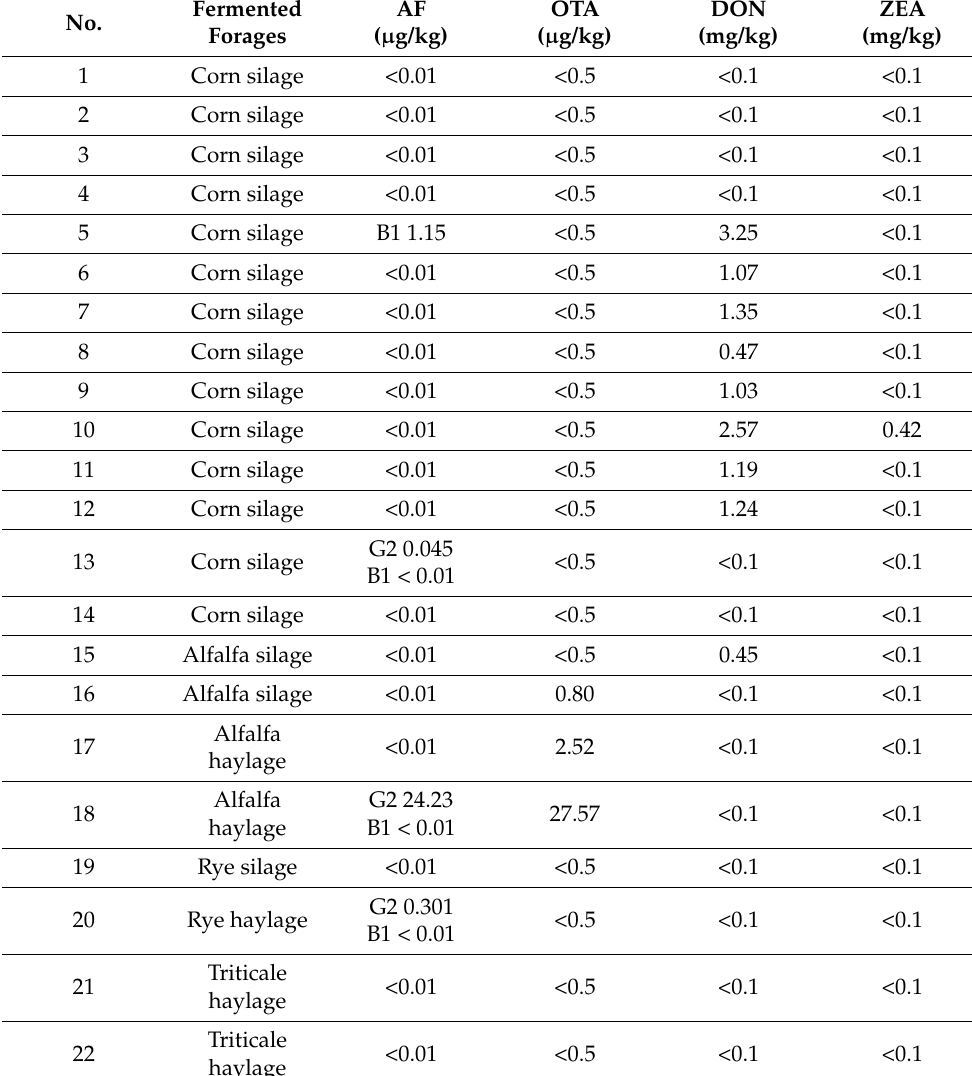
Table 1. Toxicological characterization of the studied fermented forages. Aflatoxins (AF), ochratoxin A (OTA), deoxynivalenol (DON), and zearalenone (ZEA) were measured by HPLC techniques from dried samples ( n = 3, RSD% ≤ 10%) and expressed as mycotoxin contents for dry weights of the fermented forages. The lowest detection limits (LODs) are presented where no mycotoxin could be detected.